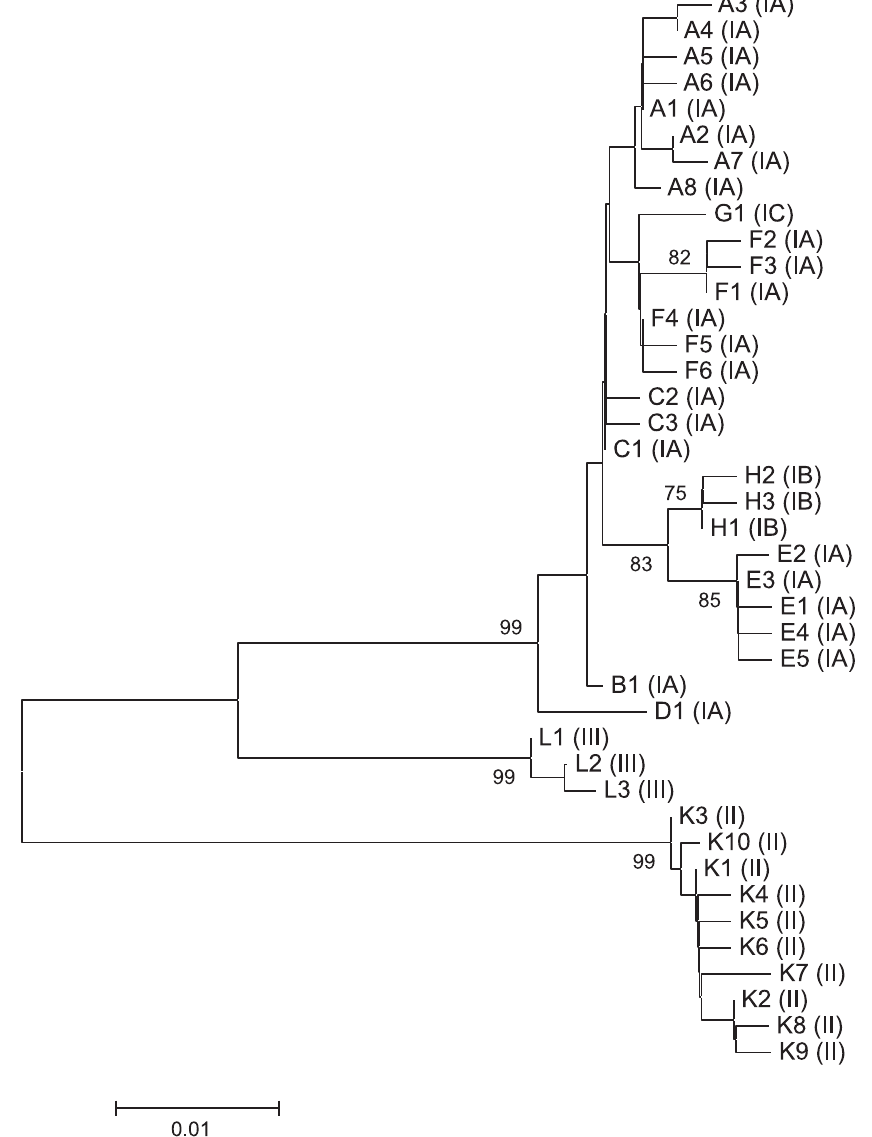
Figure 4. Minimum evolution tree generated from SLST target sequences of all 41 identified SLST types. Bootstrap values based on 500 replications and higher than 75% are